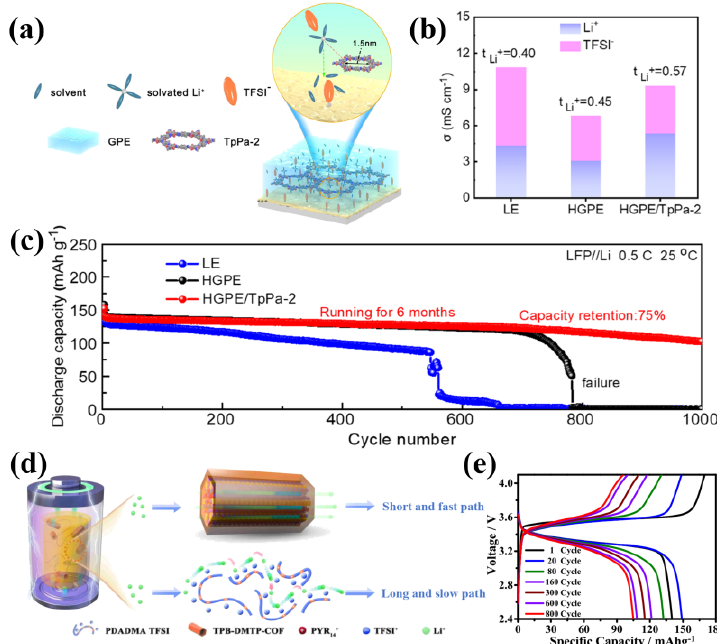
Figure 17. ( a ) Schematic illustration of desolvation behavior and structural transformation of SEI worked in HGPE/TpPa − 2; ( b ) The ionic conductivity and Li + transference number of LE, HGPE, and HGPE/TpPa − 2; ( c ) Cycle performance of LiFePO 4 |HGPE/TpPa − 2|Li full cell at 0.5 C. Reproduced with permission from Ref. [82], Copyright (2022), Elsevier.; ( d ) Schematic diagram of lithium − ion conduction path in IGE; ( e ) Charge and discharge curves of LiFePO4/IGE/Li cell. Reproduced with permission from Ref. [83], Copyright (2021), American Chemical Society.